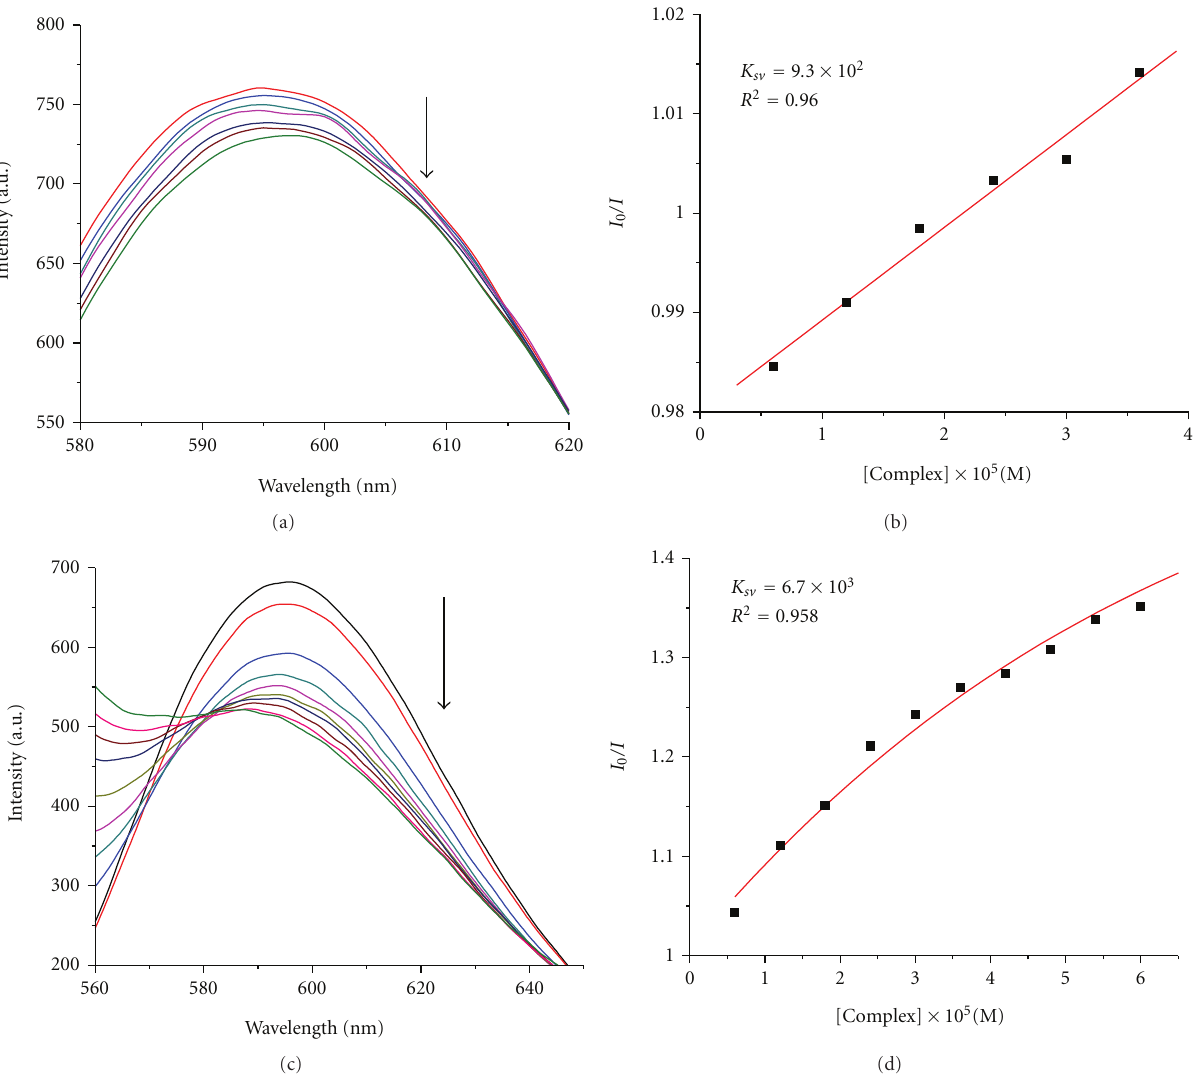
Figure 5: Emission spectra of EB bound to CT-DNA in the presence of the free buobb (a) and the Cu(II) complex (c), λ ex = 520 nm. The arrows show the intensity changes upon increasing concentrations of the complexes. Fluorescence quenching curves of EB bound to CT-DNA by the free buobb (b) and the Cu(II) complex (d). (Plots of I 0 /I versus